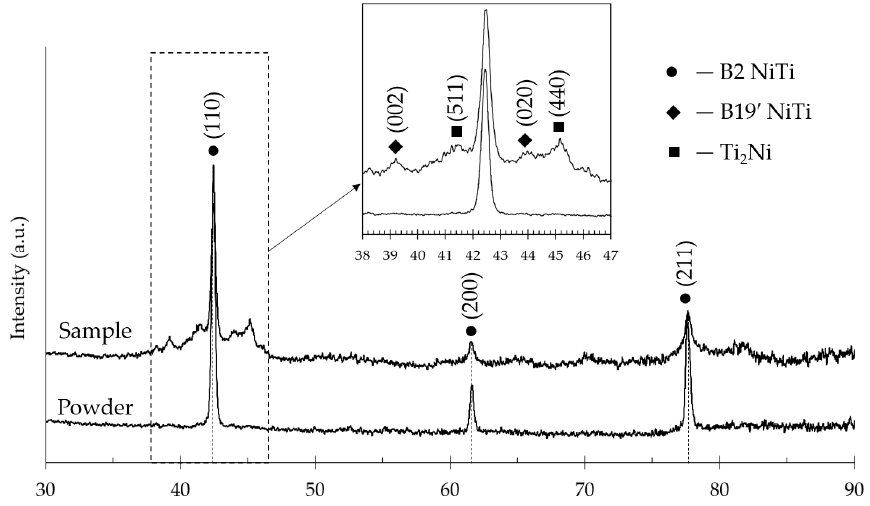
Figure 13. XRD patterns of initial NiTi powder and 3D-printed P100V850 sample.